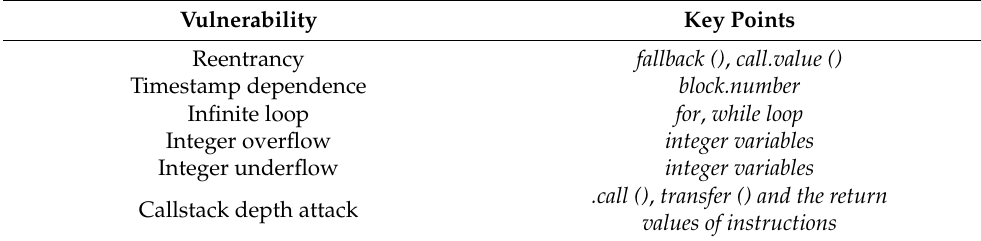
Table 2. The key points corresponding to different vulnerabilities.